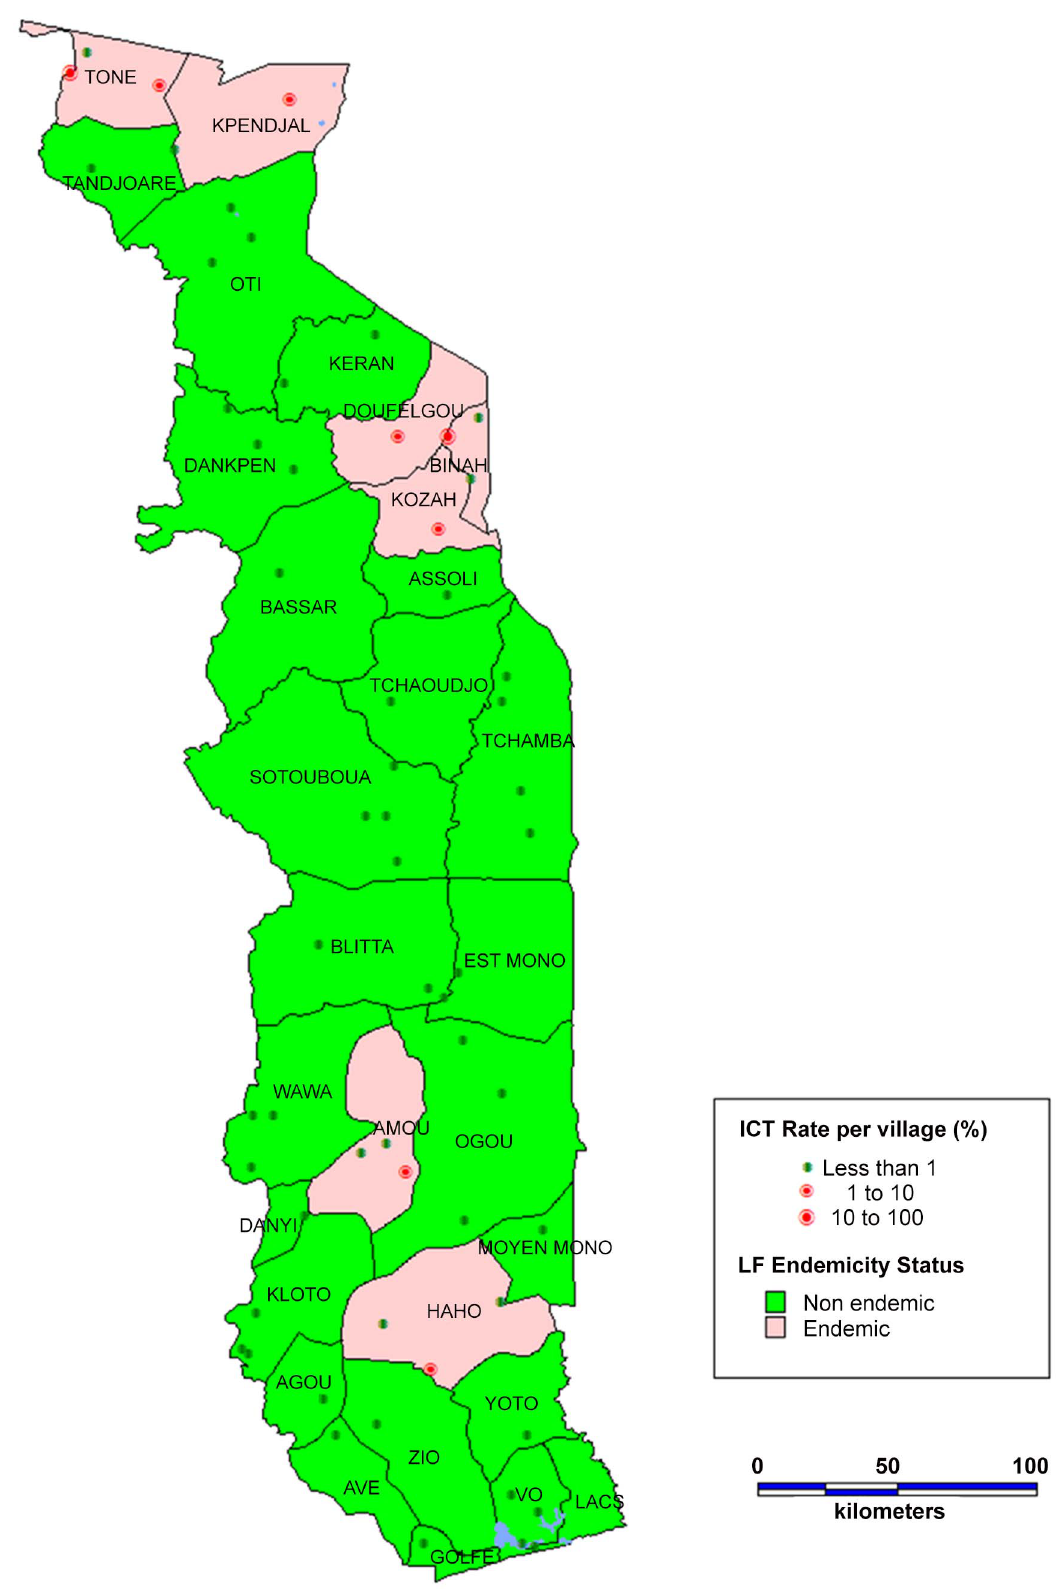
Figure 1. Districts endemic for lymphatic filariasis during the initial mapping.